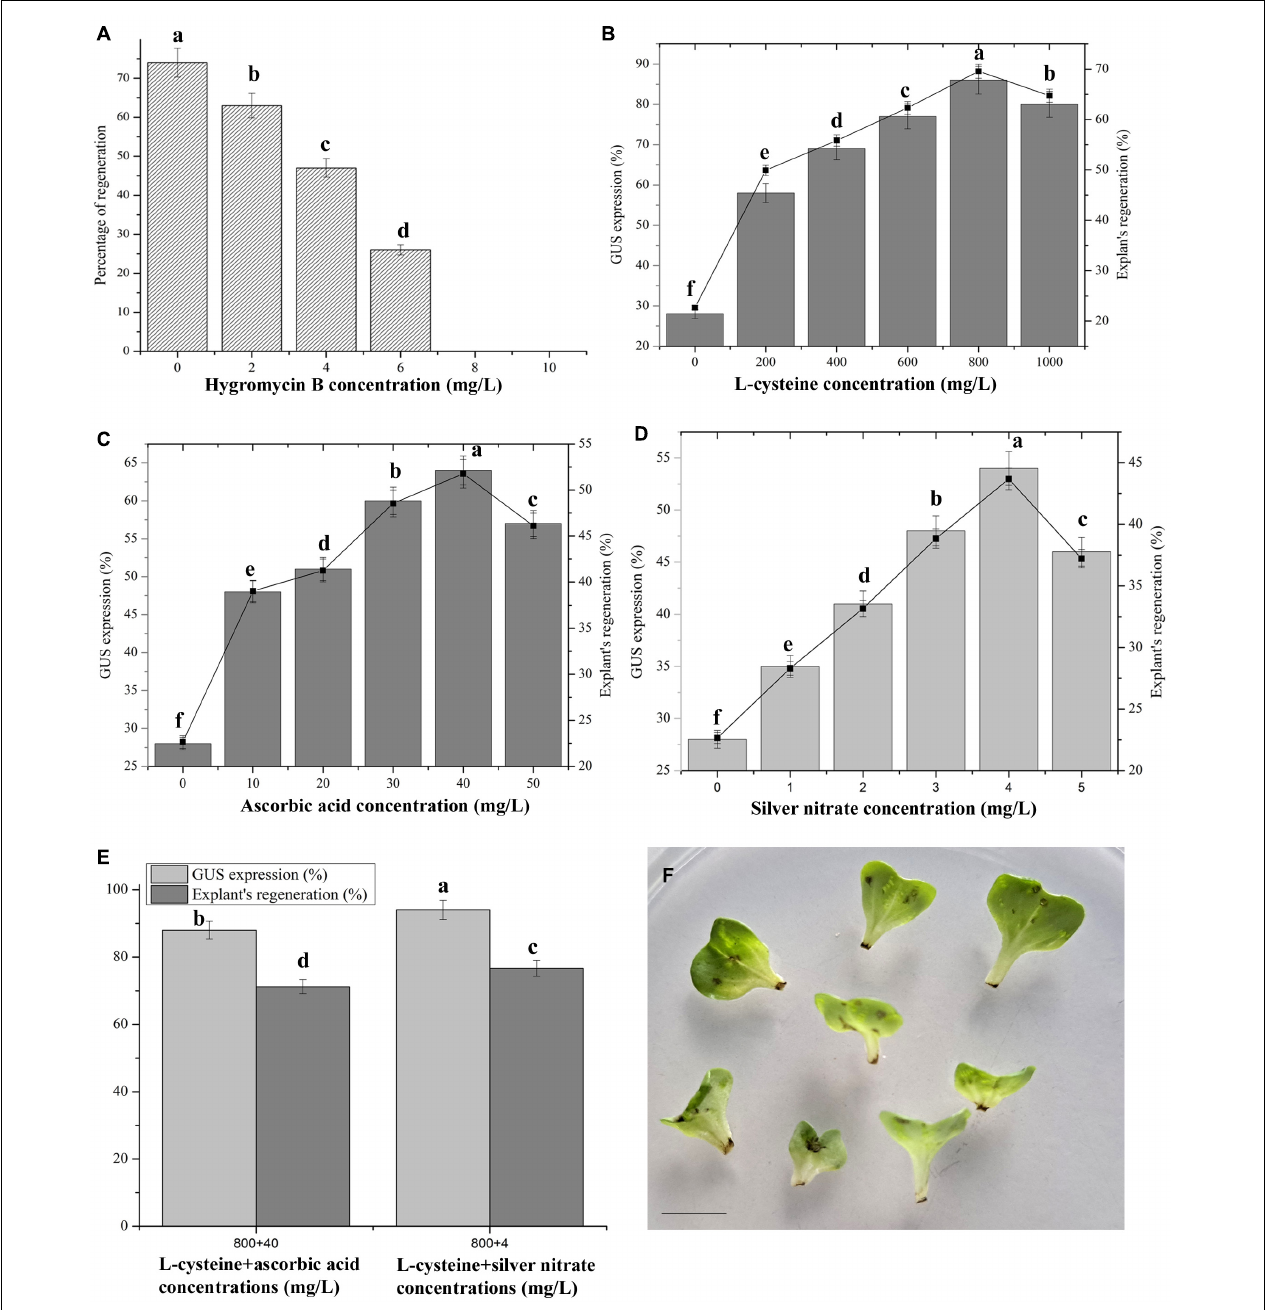
FIGURE 1 | Agrobacterium -mediated transformation in Chinese cabbage. (A) Sensitivity of cotyledon explants to hygromycin B. Effect of different antioxidants such as L-cysteine (B), ascorbic acid (C), silver nitrate (D), combined effects of best concentrations of L-cysteine + ascorbic acid, and L-cysteine + silver nitrate on GUS expression, and explant’s regeneration efficiencies (E). (F) Necrosis of petiole region of explants after Agrobacterium infection. Values represent the mean ± standard error of three replicates. One hundred twenty-eight cotyledon explants were infected for each treatment and the experiments were repeated three times. Means with the same letter above bars are not significantly different at 5% level according to Duncan’s multiple range